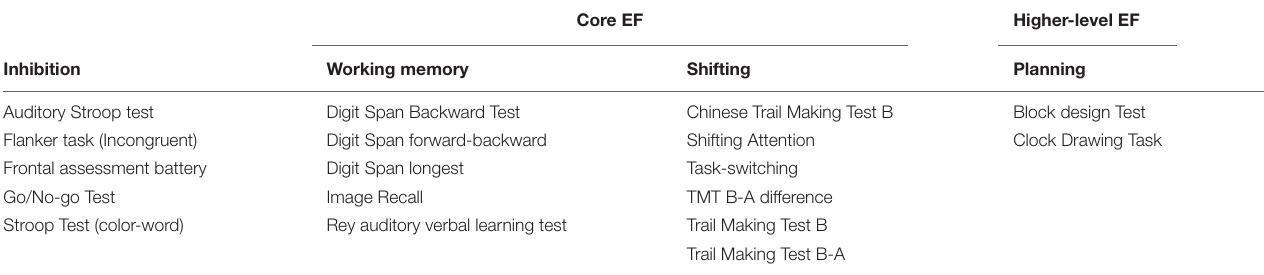
TABLE 1 | The assessments and the classification of executive function